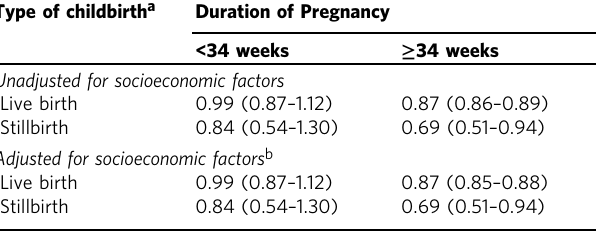
Table 2 Long-term relative risk of breast cancer after an early age childbirth compared with one childbirth less, according to the duration of pregnancy and type